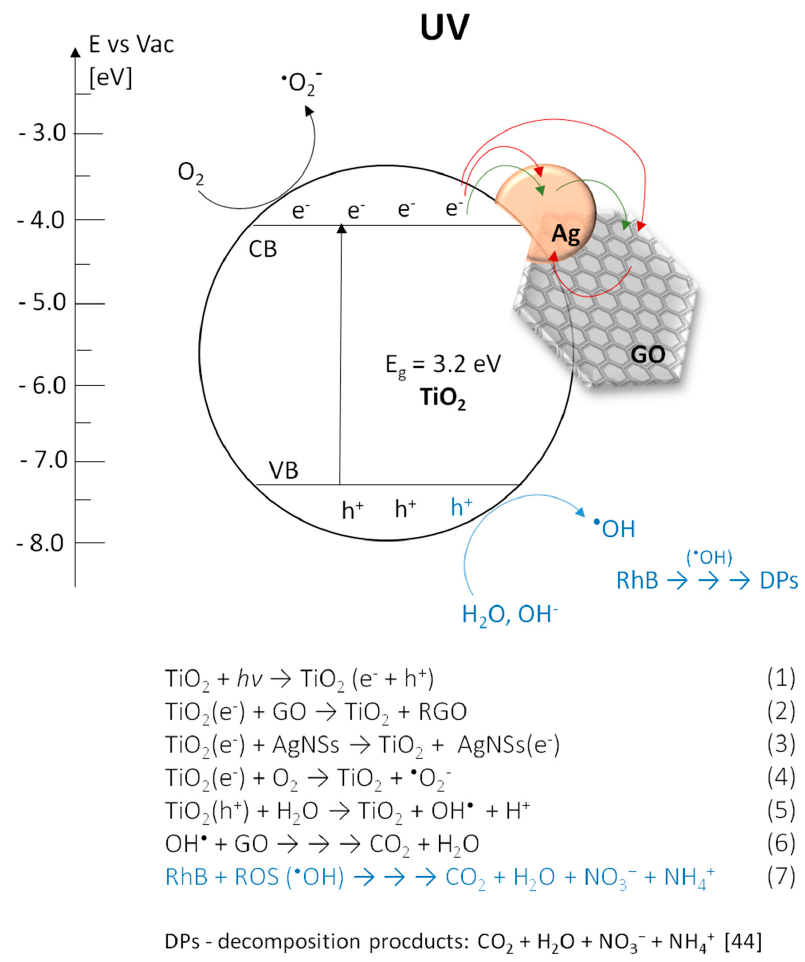
Figure 12. The reaction path [22,44,55,63] and possible photocatalytic mechanism of the three-component systems with different surface architecture occurring for photocatalysis of RhB performed under UV radiation. Green arrows correspond to the flow of electrons in TiO 2 -AgNS-GO composite. Red arrows correspond to the flow of electrons in TiO 2 -(GO-AgNS) and TiO 2 -GO-AgNS composites.